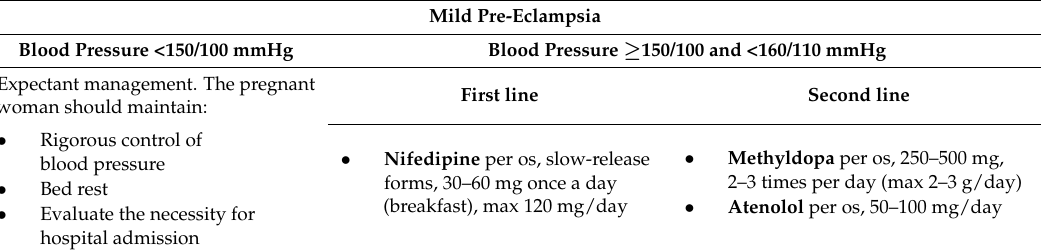
Table 3. Proposed pharmacotherapy for mild